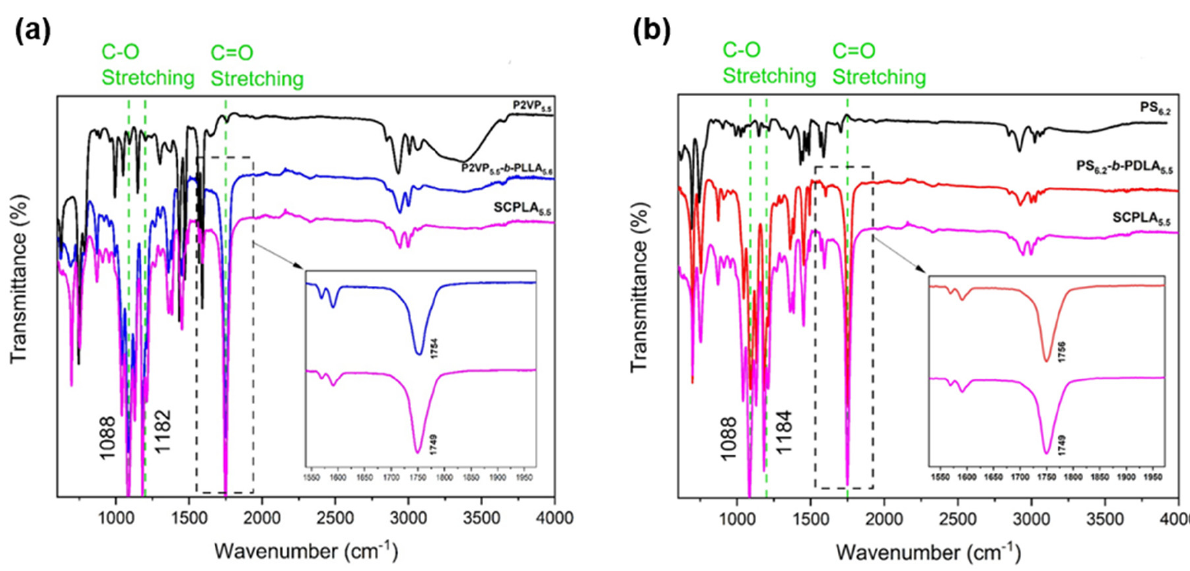
Figure 3. FT-IR spectra of ( a ) P2VP 5.5 -OH, P2VP 5.5 - b -PLLA 5.6 , and SCPLA 5.5, and ( b ) PS 6.2 -OH, PS 6.2 - b -PDLA 5.5 and SCPLA 5.5 .